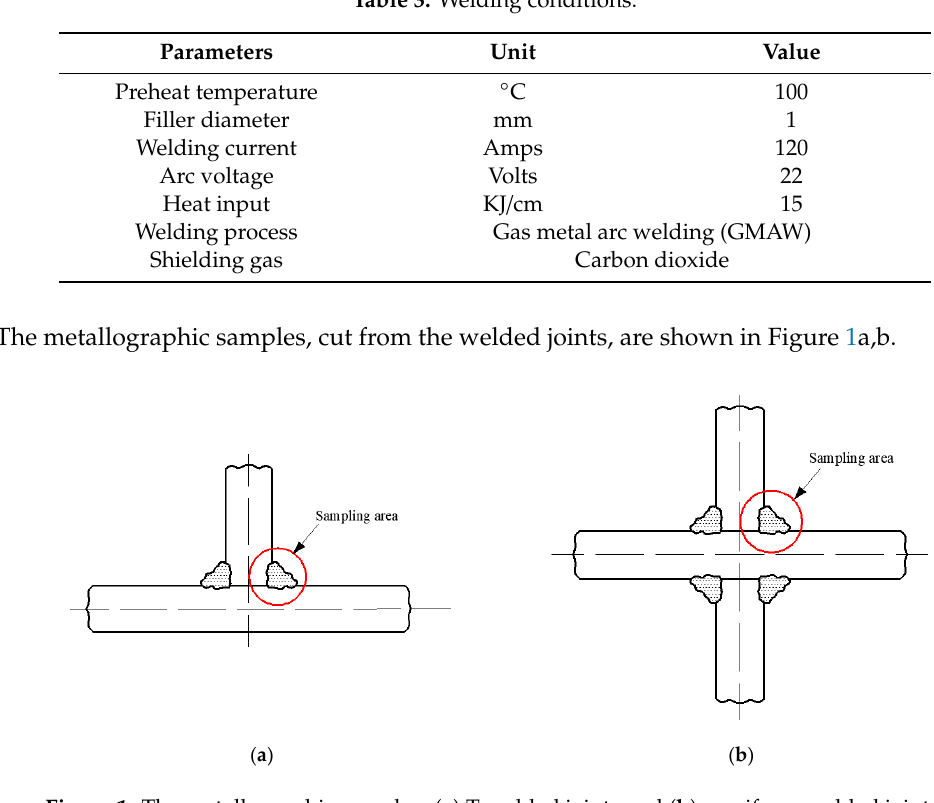
Figure 1. The metallographic samples: ( a ) T-welded joints and ( b ) cruciform welded joints. A welded joint can be divided into the welded zone (WZ), fusion zone (FZ), heat-affected zone (HAZ), and base metal (BM) [23]. As shown in Figure 2a,b fatigue failure of the specimen was predominantly located in the HAZ. Therefore, it was essential to study the microstructure of the HAZ. In this study, the microstructures of the T-welded and cruciform welded joints specimens were examined using SEM, and the various zones of the welded joints were classified.